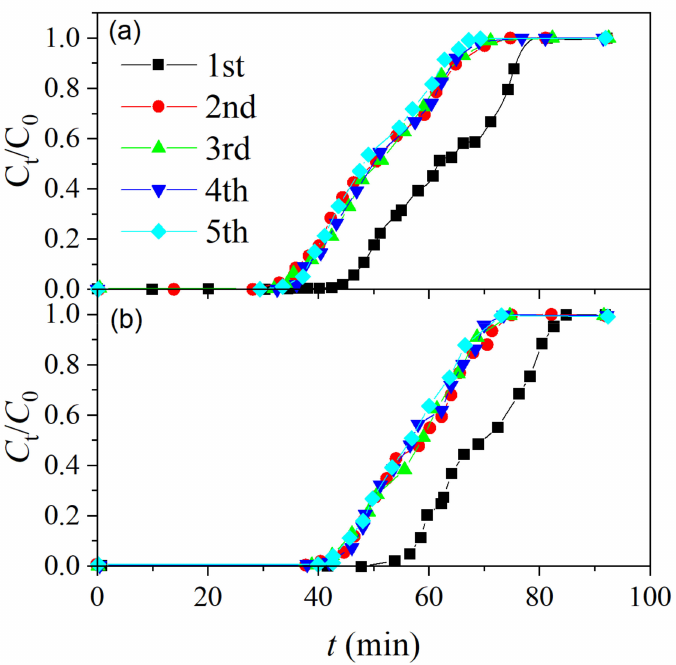
Figure 6. Breakthrough curves in five cycles of adsorption/desorption: ( a ) toluene; ( b ) ethyl